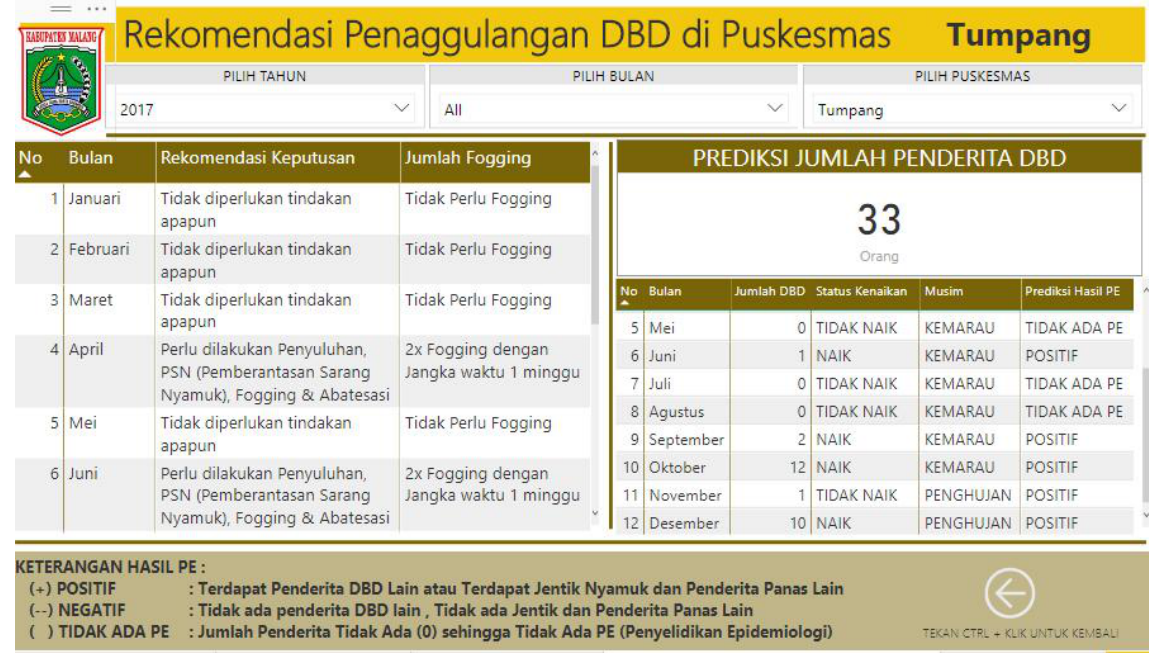
Fig. 9 Mitigation Recommendation for Each Community Health